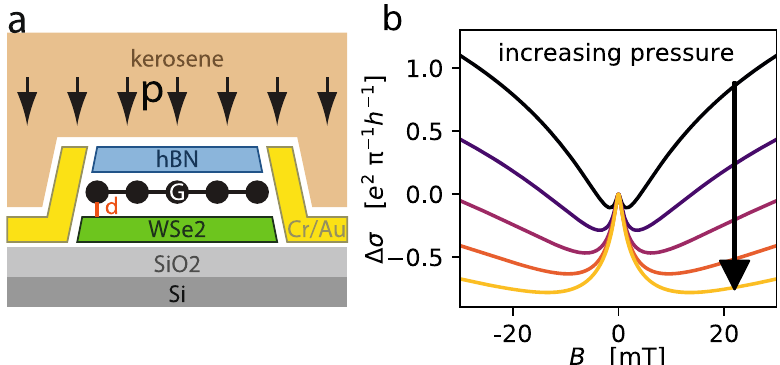
Fig. 1 Effect of the hydrostatic pressure. a Schematic side view of a hBN/graphene/WSe 2 heterostructure in kerosene pressure transfer medium. Hydrostatic pressure reduces the distance d between the graphene and the WSe 2 layers (among others), which leads to an enhancement of the proximity-induced SOC in graphene. b Simulated weak antilocalization curves using realistic parameters to demonstrate the potential effect of the application of ca. 2 GPa pressure on the heterostructure. The increased SOC leads to a more pronounced WAL peak in the magneto-conductivity curve. See Supplementary Note 1 for the simulation details.